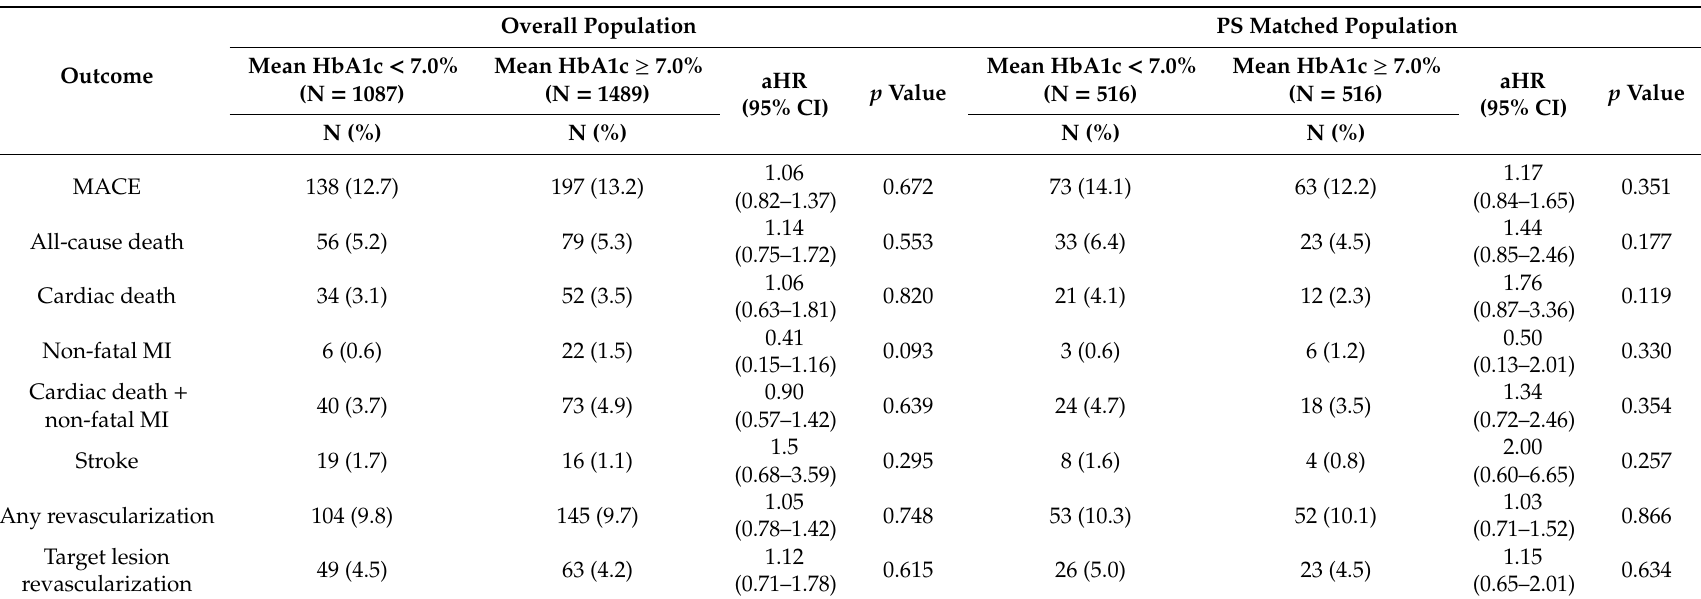
Table 2. Comparison of clinical outcomes after PCI depending on follow-up glucose control based on HbA1c